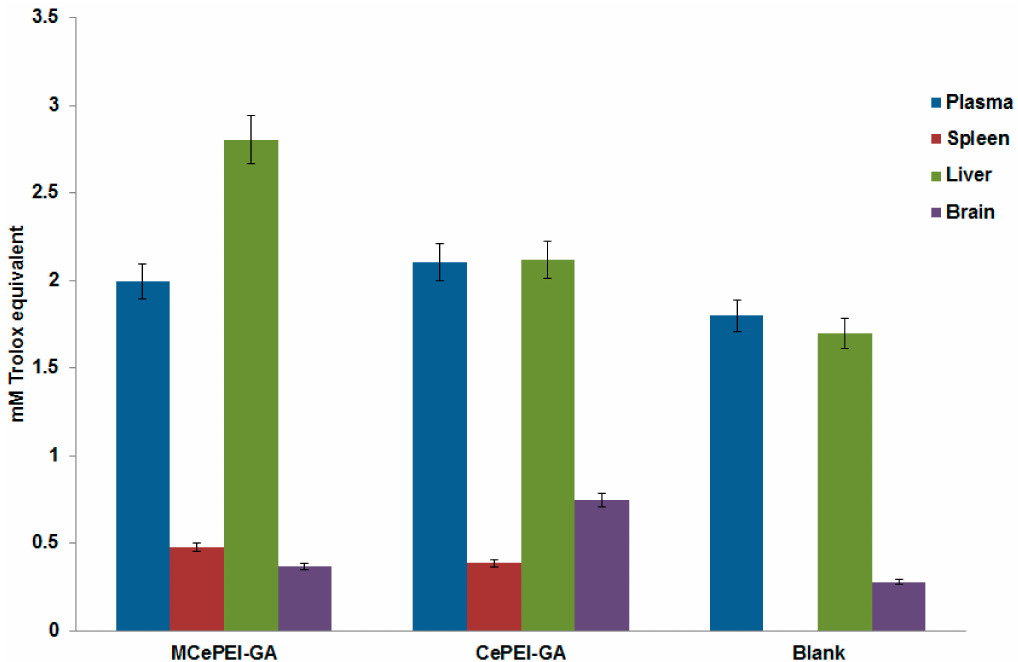
Figure 9. Total antioxidant capacity of the plasma, spleen, liver and brain collected from untreated and treated mice with antioxidant